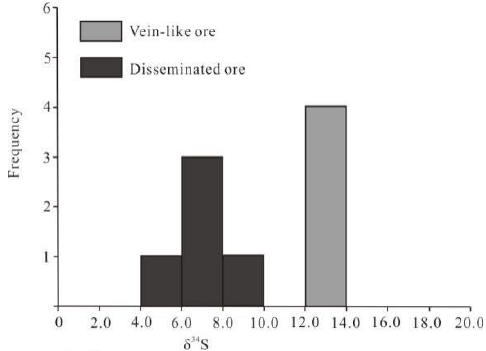
Figure 7. ε Hf (t) versus time (Ma) diagram for gabbro in Akechukesai Ⅳ mafic–ultramafic complex. Data sources for 1.8Ga, 2.5 Ga, and 3.0Ga lines are from Wu et al. [23]. Gray shadow areas are from Li et al. [6] and a compilation of literature data.